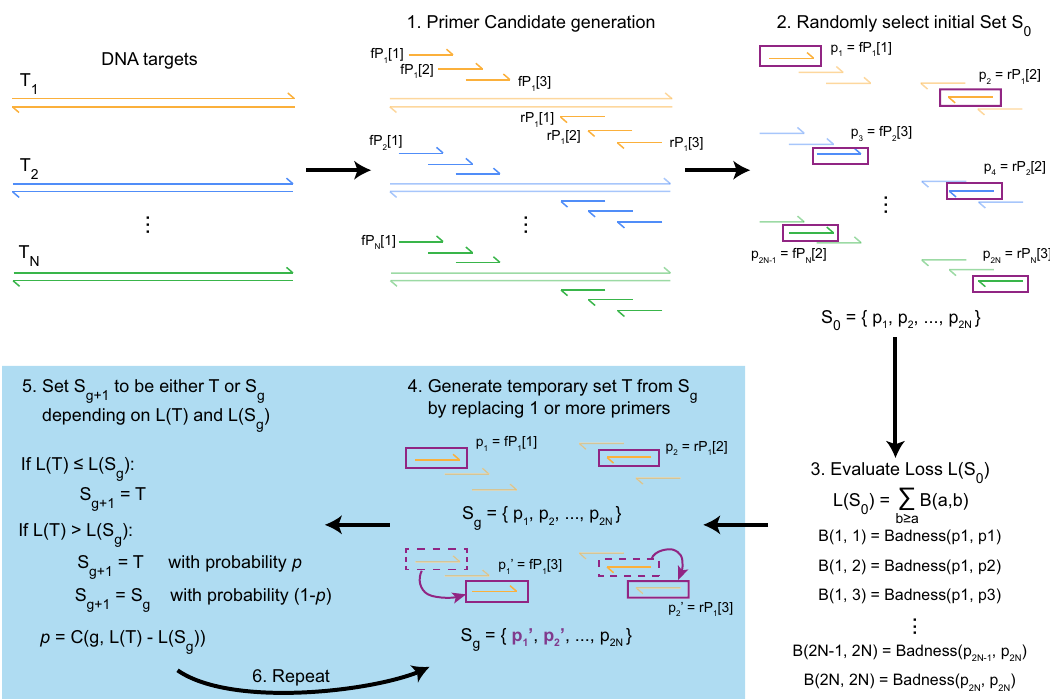
Fig. 1 Overview of Simulated Annealing Design using Dimer Likelihood Estimation (SADDLE). Given a set of DNA target sequences { T 1 , T 2 , ..., T N }, the goal is to design a total of 2 N PCR primers that can effectively amplify all DNA targets, while generating an acceptably low amount of primer dimer species. Steps 4 and 5 can be repeated a large number of times in order to improve (decrease) the Loss function value on the fi nal primer set S. Multiple implementations, hyper-parameters, and parameters can be selected for each SADDLE step that can impact performance and